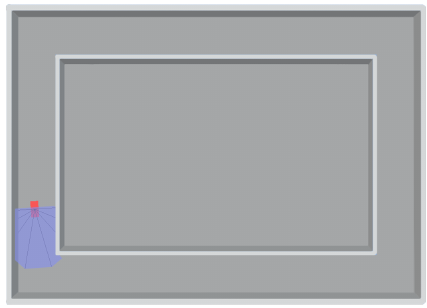
Figure 6. Obstacle avoidance task. The agent measures distance from obstacle with 8 sonars.